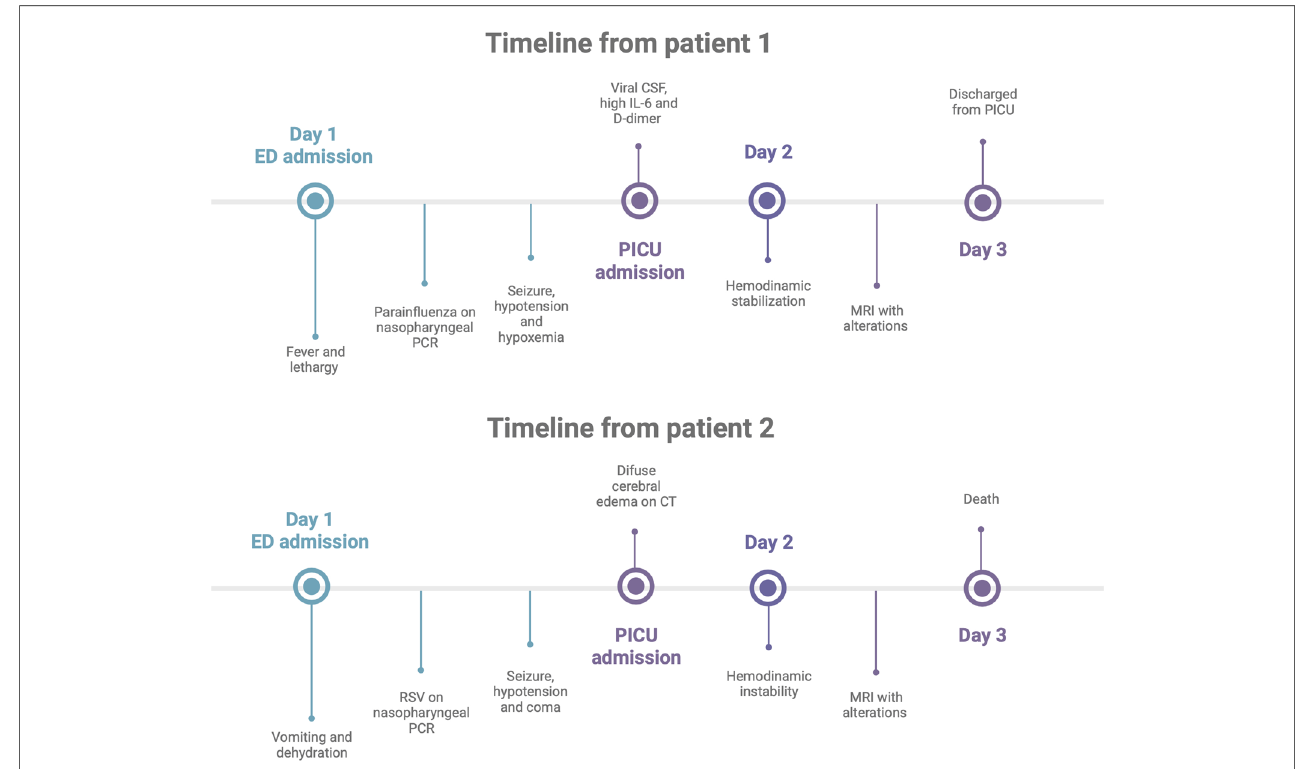
FIGURE 1 Patients ’ clinical event timeline: graphical